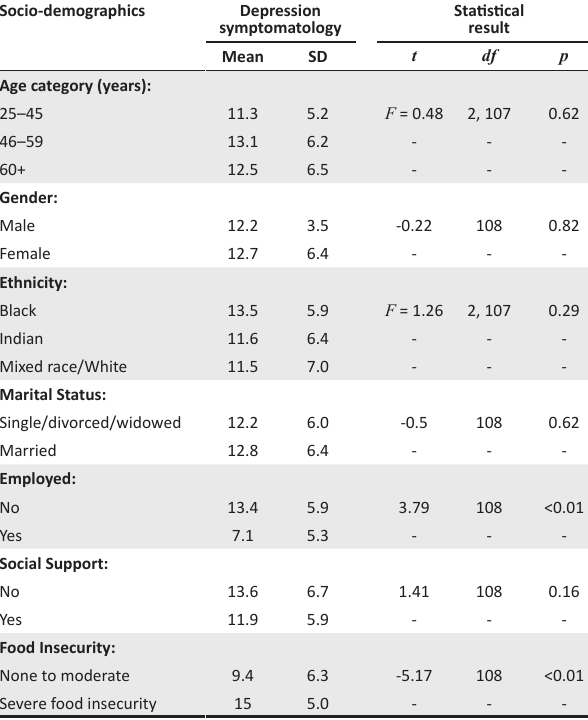
TABLE 3: Association of depression symptomatology by socio-demographic data in rheumatoid arthritis participants. Socio-demographics